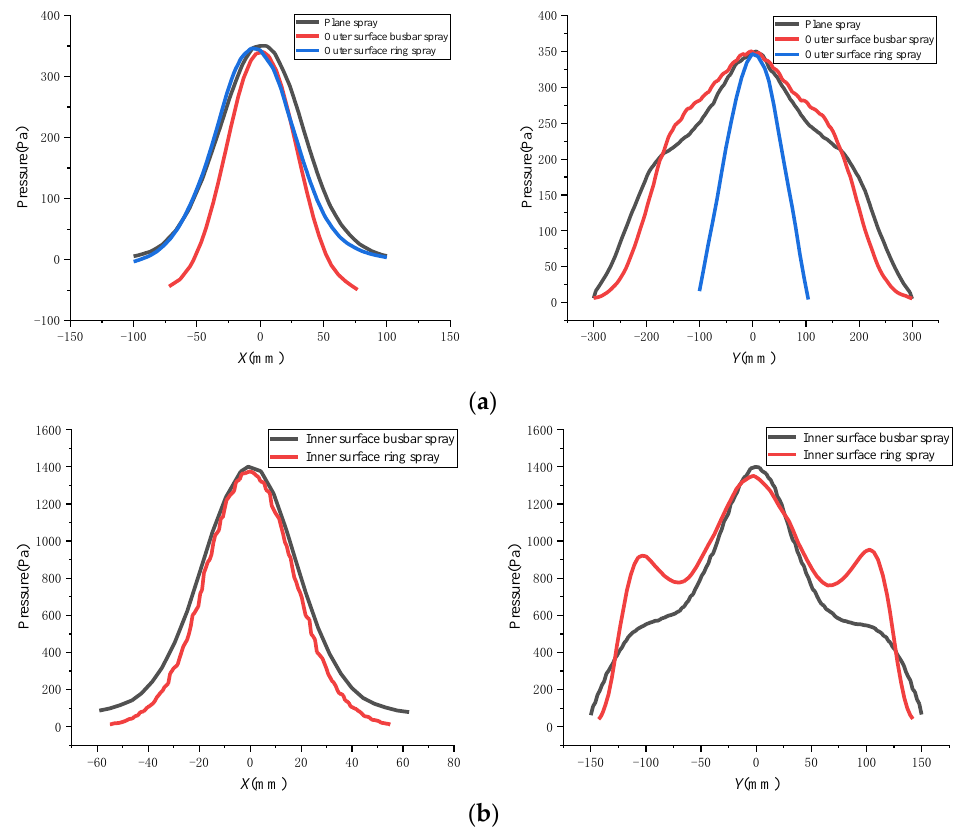
Figure 12. Pressure distributions near the wall. ( a ) Plane spraying and outer surface spraying pressures. ( b ) Inner surface spraying pressure.